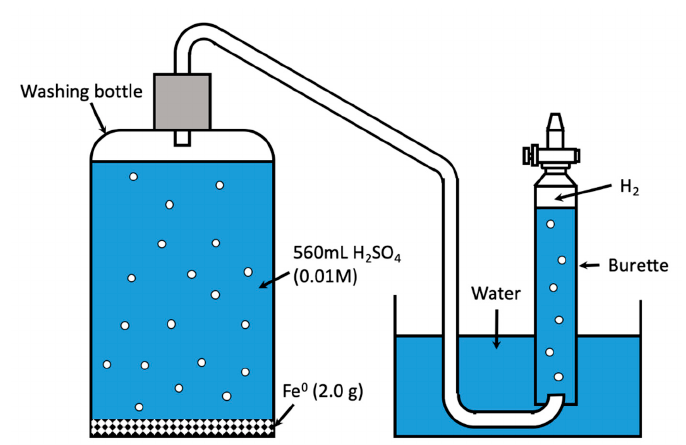
Figure 2. Schematic diagram of the pneumatic trough for the collection of H 2 . H 2 generated in the washing glass induces the displacement of water in the inverted burette. The H 2 volume corresponds to that of displaced water.